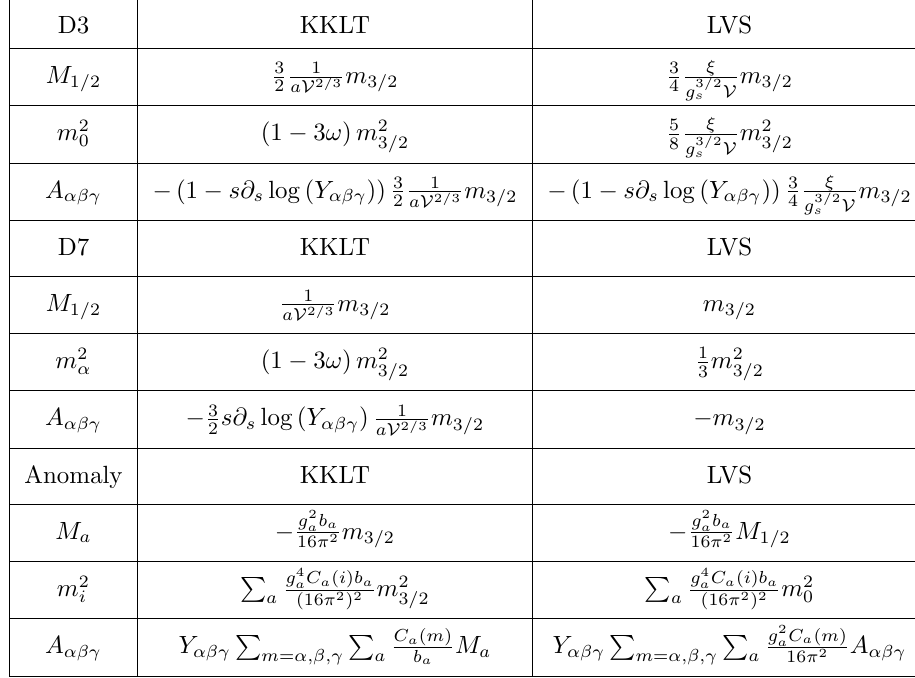
Table 1 . Soft masses for KKLT/LVS with standard model (cid:12)elds realized on D3/D7 branes. Here g a is the gauge coupling, the parameter b a is de(cid:12)ned as b a = 3 T G (cid:0) T R , with the Casimir invariant T G in the adjoint representation, the Dynkin index T R and the quadratic Casimir invariants in the fundamental representation C a ( i ). The parameter ! is a function of the coe(cid:14)cients of the K(cid:127)ahler matter